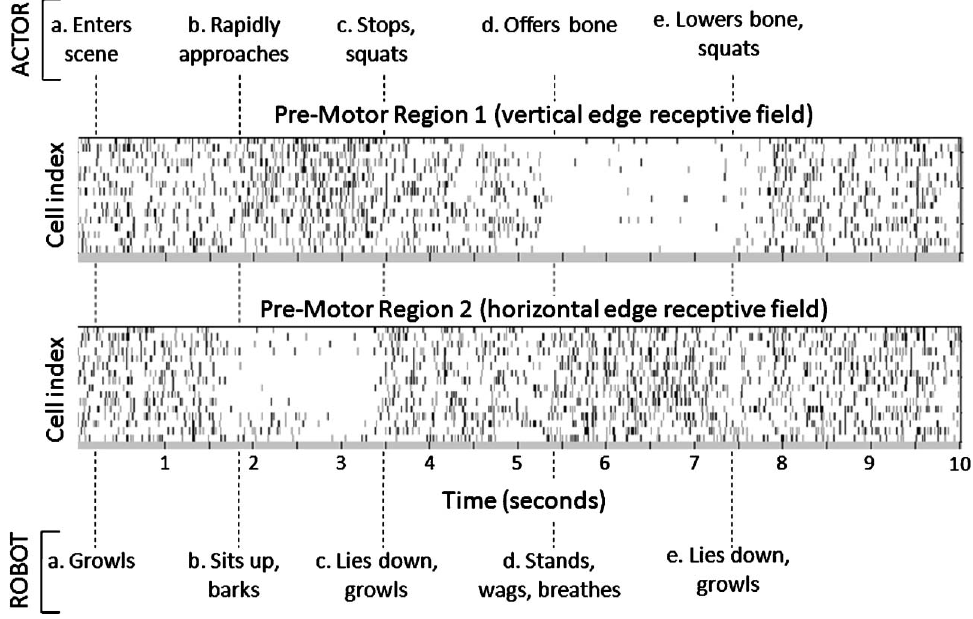
Figure 3. ACTOR-BRAIN-ROBOT interplay . Ten-second behavior scenario indicating timing of ACTOR (upper row) and ROBOT (lower row) events. The ACTOR in this scenario was free to choose any sequence of movements in response to perceived intent of the ROBOT. ROBOT behavioral sequences are triggered when the neuromorphic BRAIN output to BRAINSTEM has 50ms of consistent spiking in one pre-motor region compared with another. Periods without domination of one pre-motor region over another trigger the ROBOT to lie down and growl. In cell rasters, each row represents the timing of action potentials (spikes) of a single neuron; darker gray markers indicate clustered bursts of spikes.